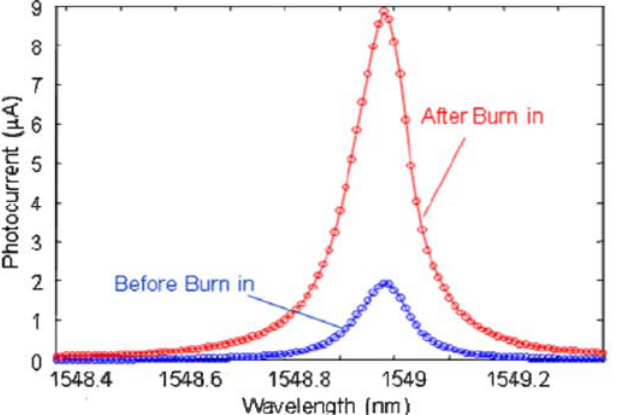
Figure 10. Photoresponse of a 15- μ m-radius-ring detector at − 2 V [54]. Reprinted with permission from R. Shafiiha, et al. Copyright © 2010